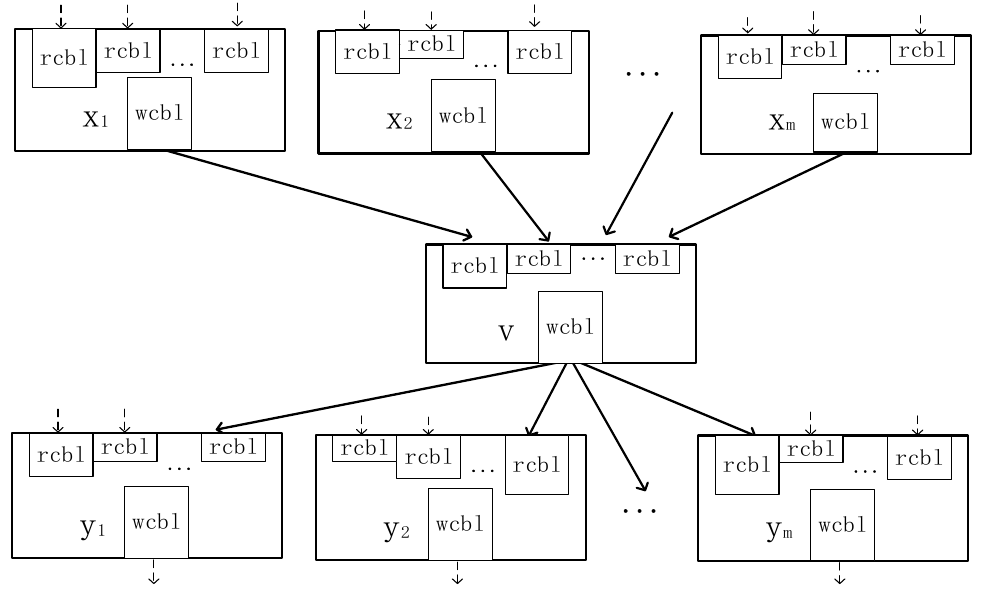
Figure 6. DAG describing the task with the buffer queue length.